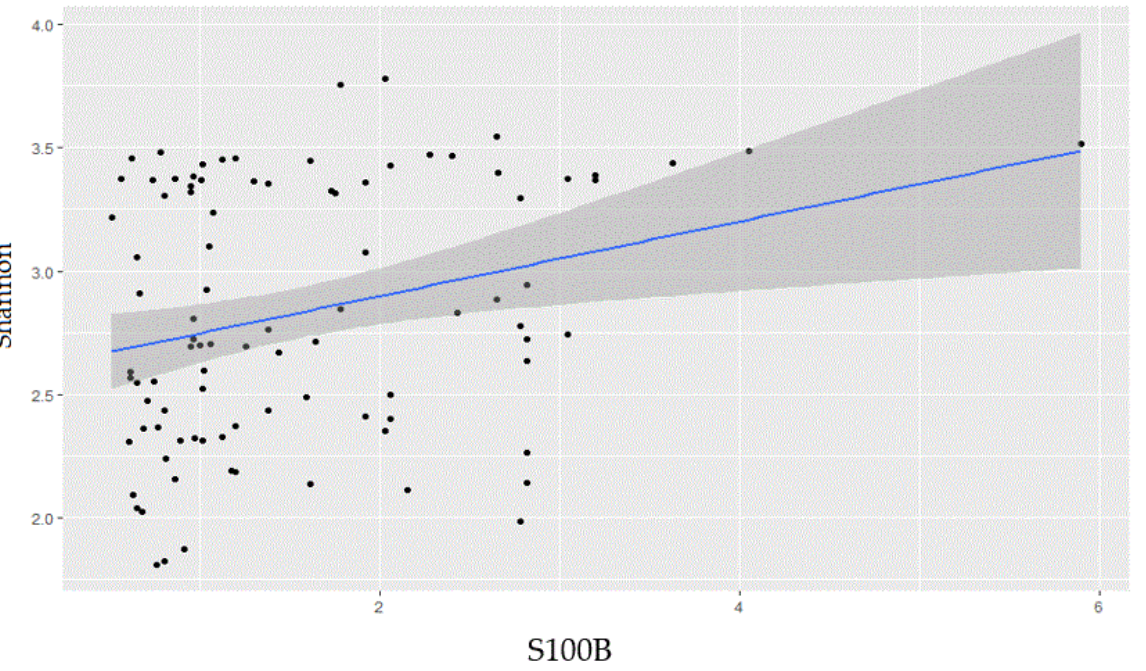
Figure 1. Relationship between concentration of S100B and Shannon alpha-biodiversity index. The scatterplot shows a positive correlation between S100B concentration (ng/mL) and Shannon values. The regression equation was Y = 0.15X + 2.59 without the 0 values (intercept 2.4 – 2.8).